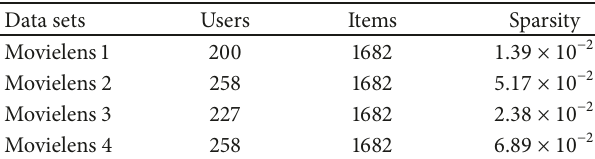
Table 1: Properties of the Movielens data sets.